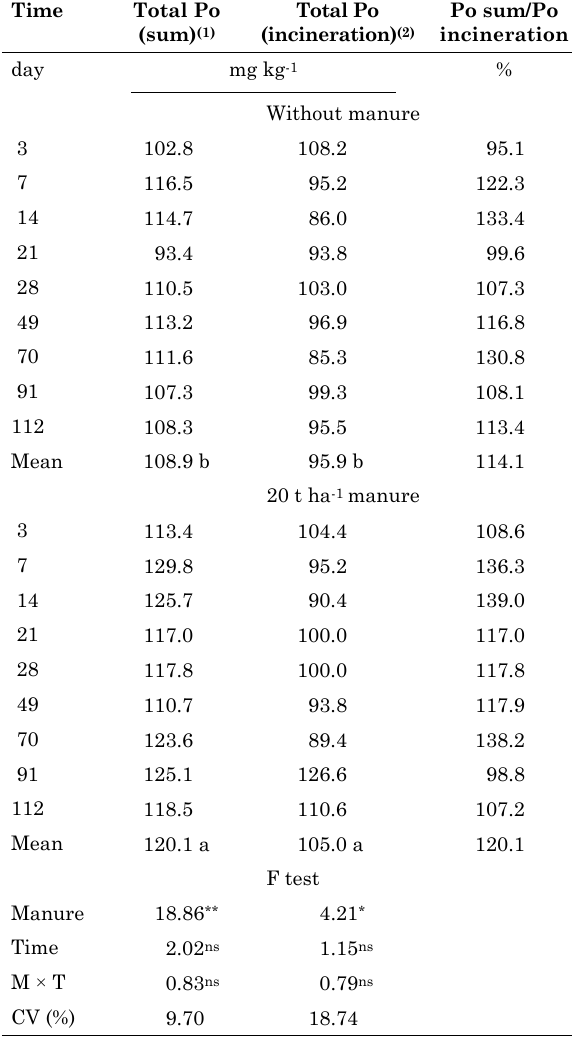
Table 4. Total organic P obtained by the sum of fractions and by incineration, determined in samples of a sandy-clay loam Haplustox fertilized or not with cattle manure, evaluated during 112 days of